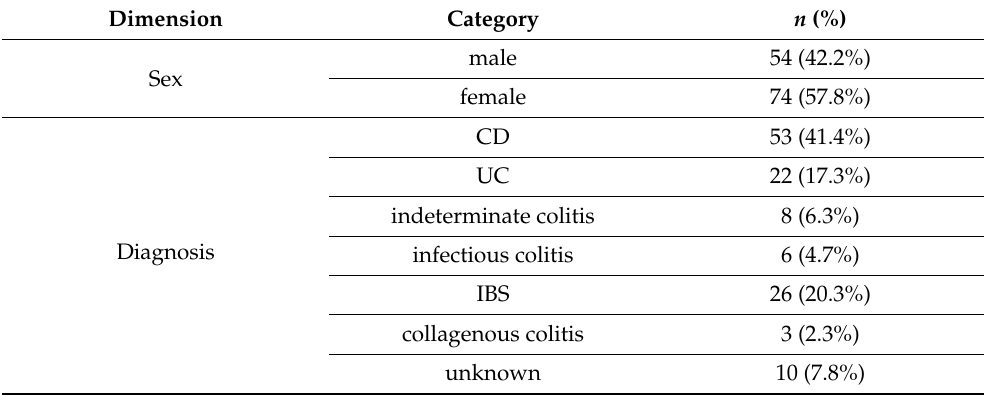
Table 1. Patient demographics of all patients with colitis: CD, Crohn’s disease; UC, ulcerative colitis; IBS, irritable bowel syndrome.